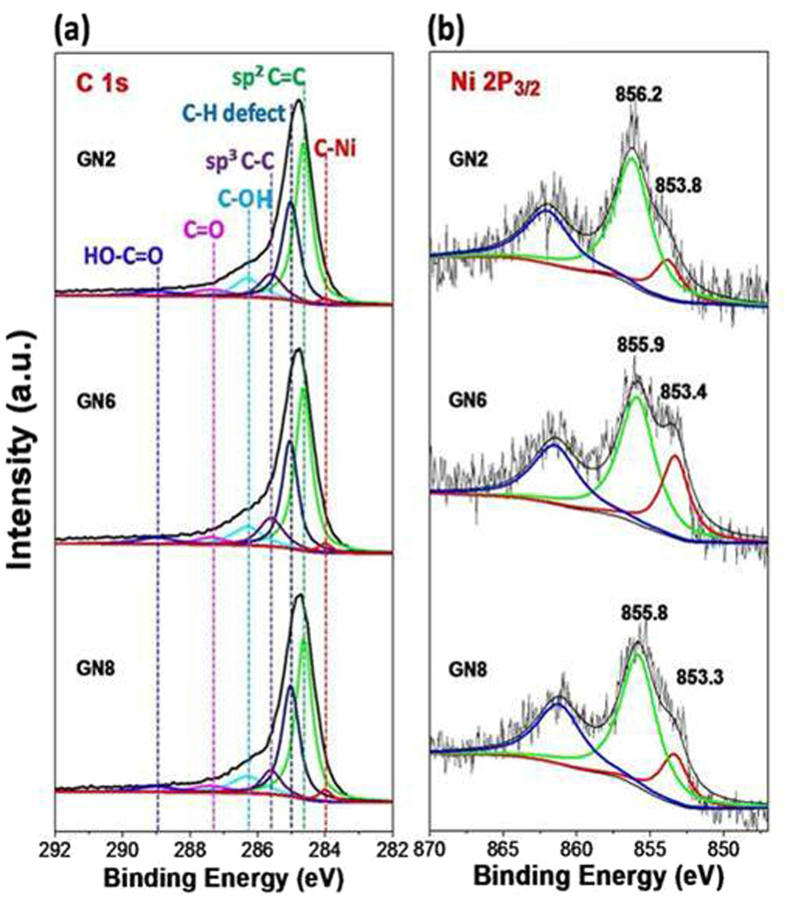
High resolution XPS spectra of C 1s (a), and Ni 2p3/2 (b) for GN2, GN6, and GN8.